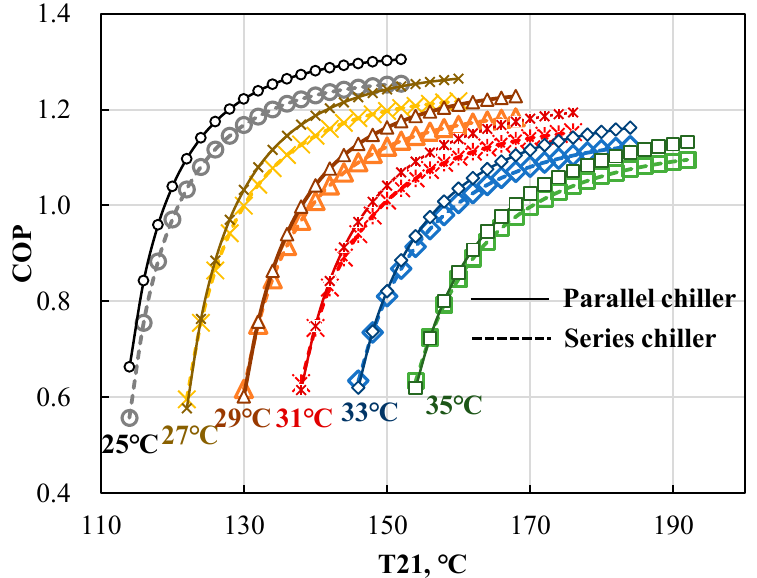
Figure 4. Variation of COP with two types of absorption chillers as function of cooling temperature and steam temperature (T21).